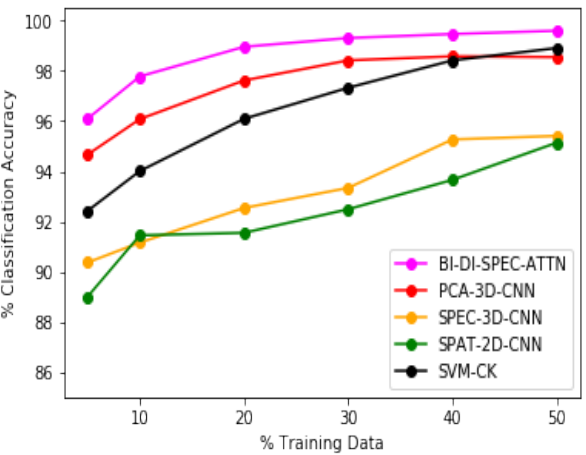
Figure 5. Overall classification accuracies on Salinas dataset for varying sizes of training samples.